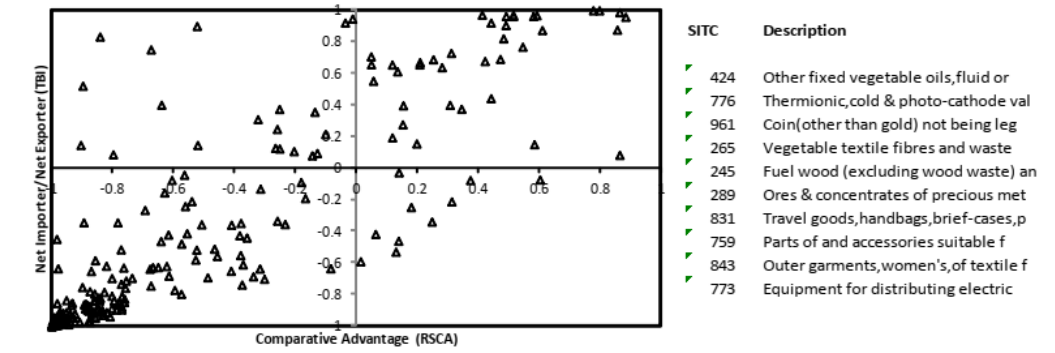
Figure 12: Products Mapping and the Top-Ten Export Products of Philippines,